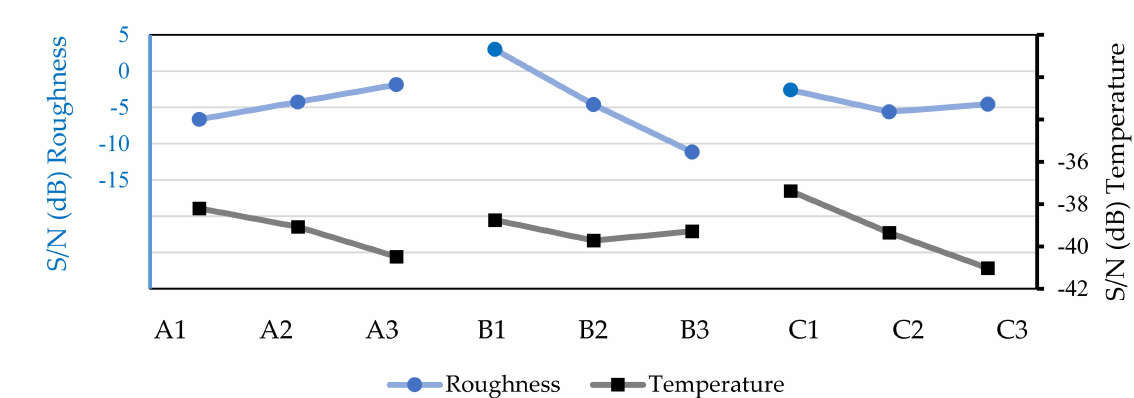
Figure 6. S/N values for surface roughness of the workpiece and chip temperatures based on the machining tests with Balis Mafcool 51 (50 mL/h).